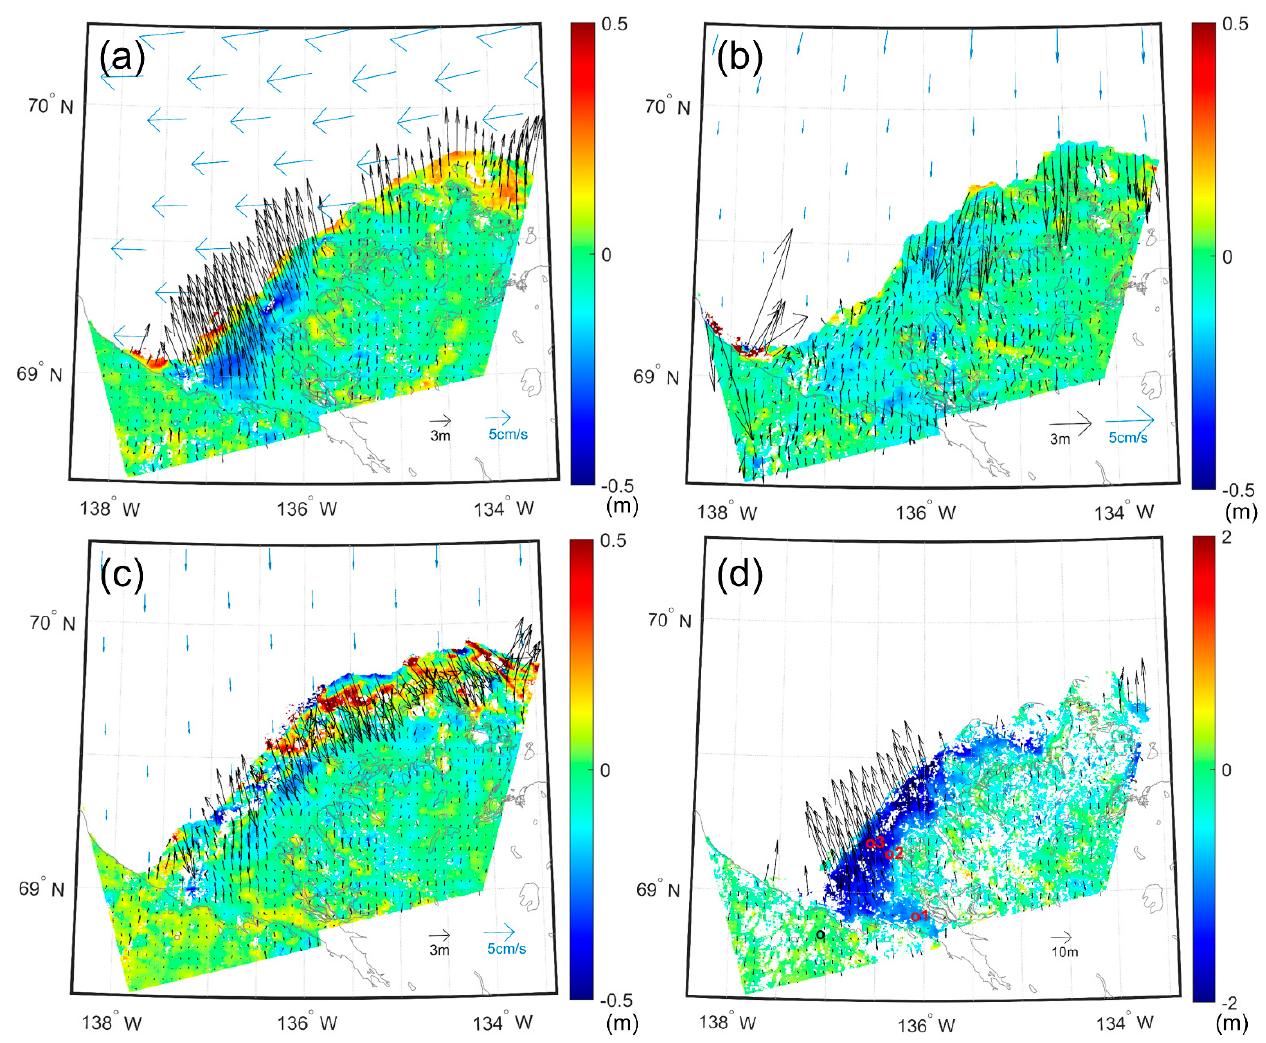
Figure 5. 3D SPO results. ( a ) 20180113–20180125. ( b ) 20180125–20180206. ( c ) 20180206–20180302. ( d ) Total cumulative off- sets between 20171126 and 20180407. The color bars represent vertical offsets and the black arrows represent horizontal offsets reconstructed from east-west and north-south offsets. The pale blue arrows represent the averaged drift sea ice motions during the same period. Note that the sizes of the arrow scale bars vary relative to the changes for each period. The black (land) and red (landfast ice; LFI 1–3) circles represent the spots for time-series analysis in Figure 7.